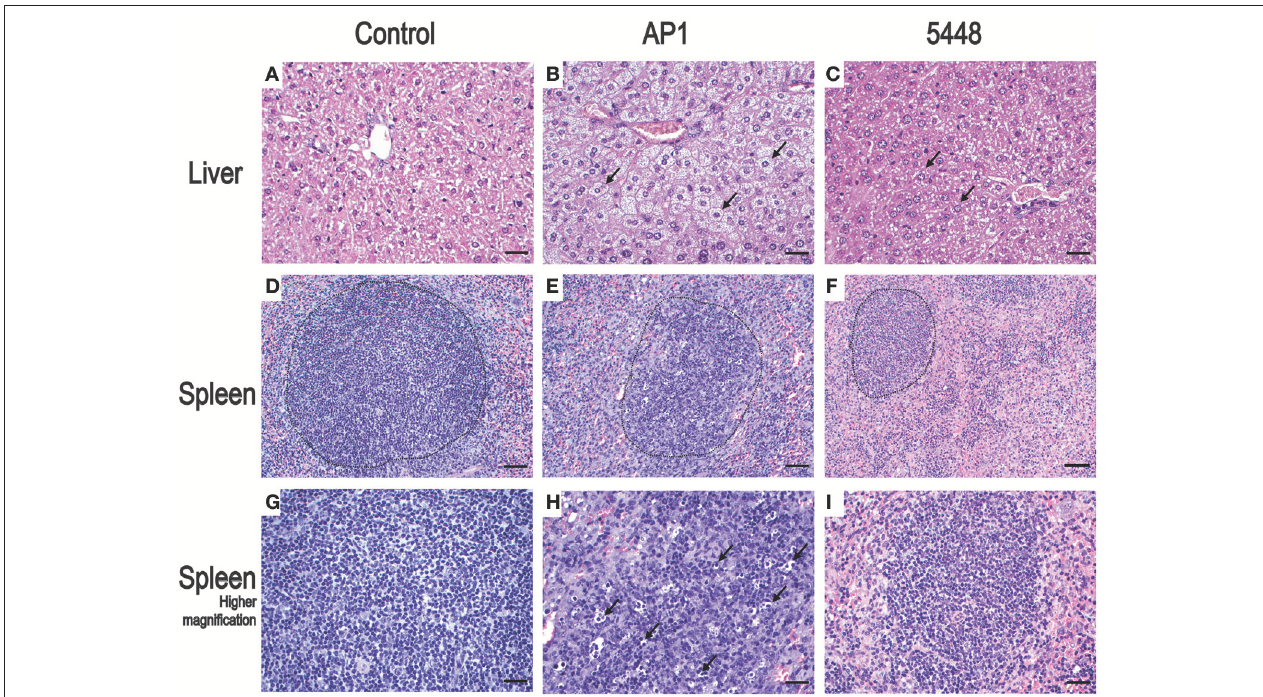
FIGURE 2 | Representative H&E stained sections of the most salient changes seen in internal organs 40h p.i. Top row (A–C) liver; microvesicular fatty change (intrahepatic vacuolization) in hepatocytes consistent with steatosis is seen in AP1 infection (B) but not in controls (A) or 5448 infection (C) (bars = 25 µ m). The arrows point to selected representative hepatocytes. Middle row (D–F) spleen; granulocytosis and apoptosis of lymphoid cells and blurring of the border between white and red pulp in AP1 infection (compare E to D and F ). The dotted lines delineate areas of white pulp (bars = 50 µ m). Bottom row (G–I) higher magnification (bars = 25 µ m) of white pulp. The arrows in (H) point to pyknotic lymphocytes amost exclusively seen in AP1 infection (compare H vs. G and I ).